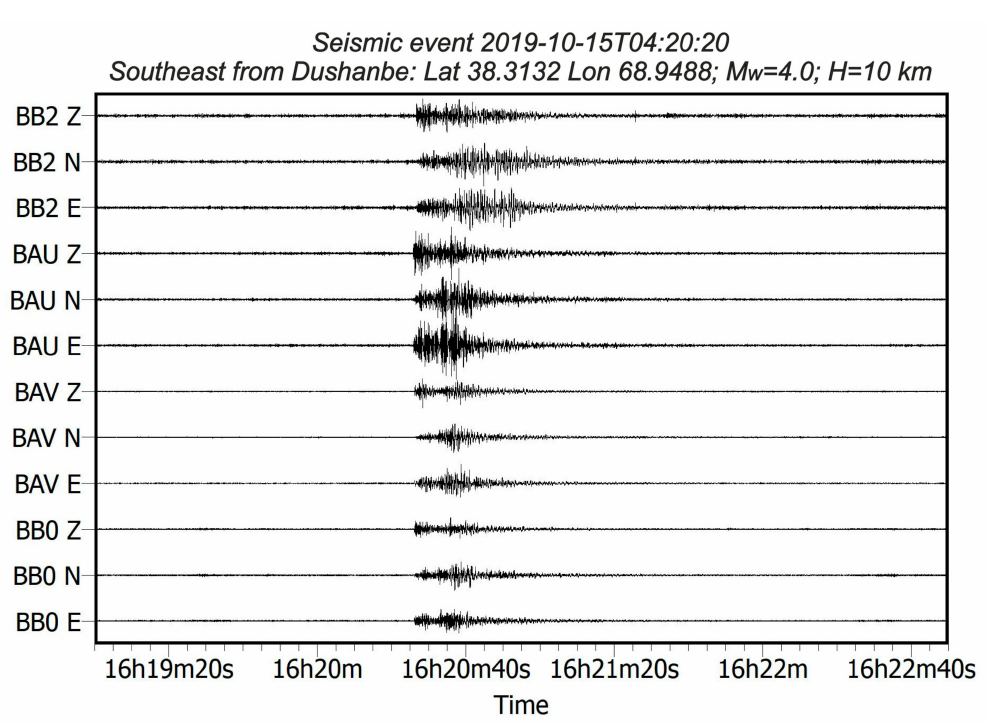
Figure A1. Examples of triaxial seismograms (E for E-W, N for N-S, and Z for vertical) for one of the five events recorded at other four stations (BAU, BB2, BB0, and BAV). The epicenter of the 4.0–event is 30 km southeast of